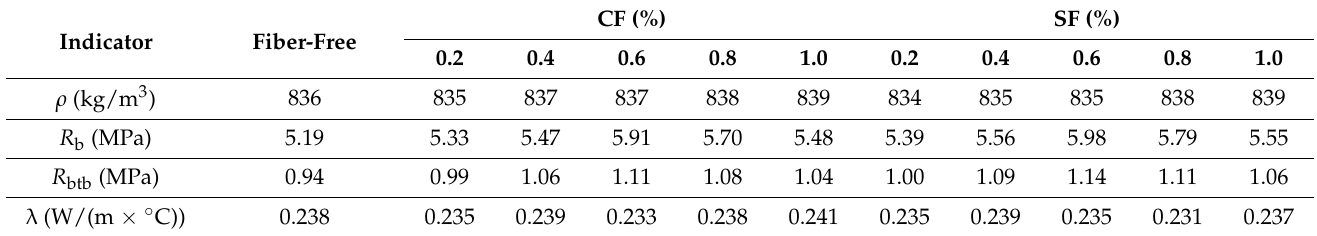
Table 13. Physical and mechanical characteristics of non-autoclaved aerated concrete modified with FA, with different dosages of SF and CF. Table 14. Physical and mechanical characteristics of non-autoclaved aerated concrete modified with GGBS with different amounts of CF and SF.